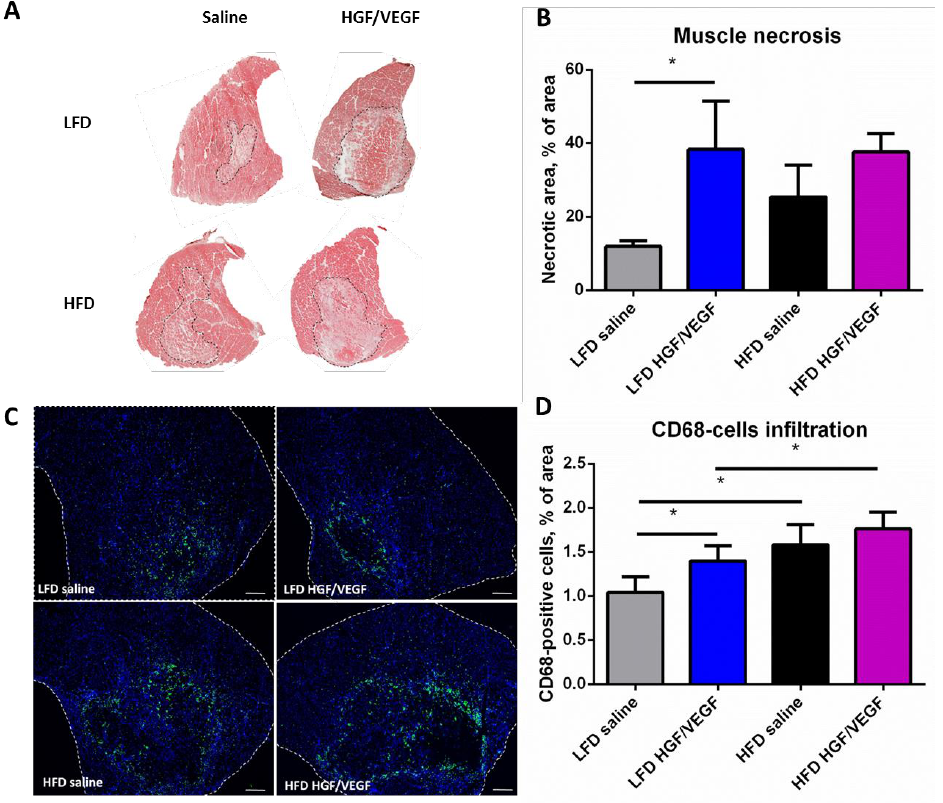
Figure 4. HGF/VEGF plasmid injection enhances ischemic-induced necrosis and macrophage infiltration under LFD conditions, but does not affect post-ischemic recovery process under HFD conditions. (10+3 weeks of experiment). ( A ) representative images of hematoxylin/eosin stained m.tibialis anterior sections, dotted line has marked necrotic area; ( B ) statistical analysis of necrotic area morphometry data; ( C ) representative images panel of CD68+ cells infiltration in m.tibialis anterior , scale bar 200 um, dotted line has marked muscle area; ( D ) statistical analysis of CD68+ cells infiltration data. Data is presented as mean ± SEM; Kruskal –Wallis test with post hoc Dunn’s test; * p < 0.05.